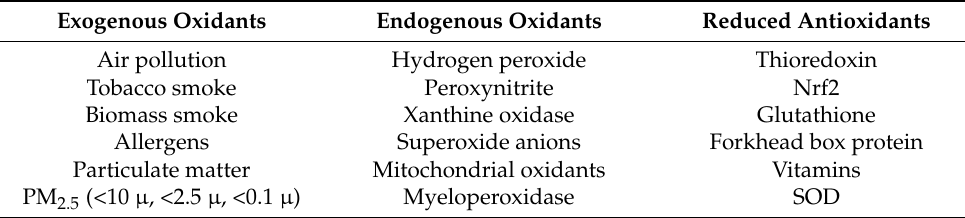
Table 1. Sources of oxidative stress in respiratory diseases.